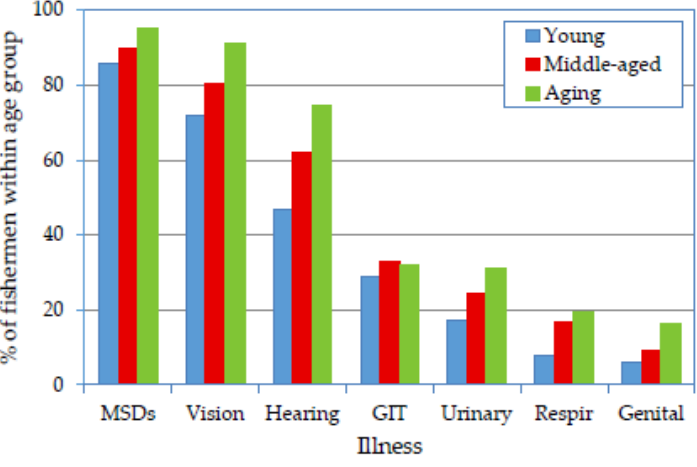
Figure 4. Prevalence of major illnesses reported by fishermen according to age group.